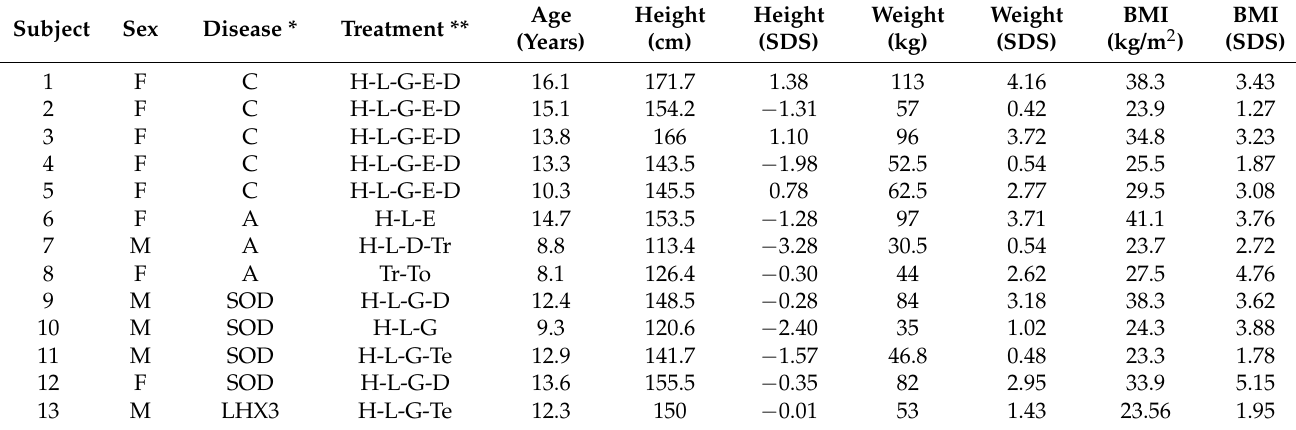
Table 1. Main baseline clinical and auxological data of the 13 enrolled